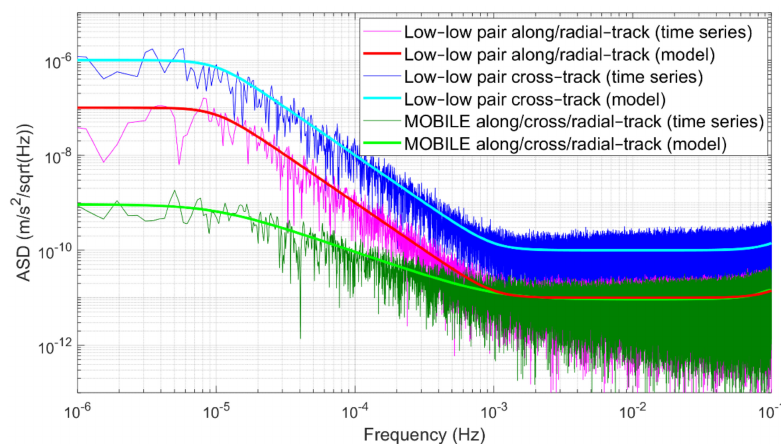
Figure 4. Amplitude spectral density (ASD) of the relative acceleration measurement error in terms of accelerations for the low–low pair formation (dark blue and magenta) and for MOBILE (dark green). The generation of the noise time-series was done by scaling the spectrum of normally distributed random time-series with their individual spectral model (light blue, red, and light green